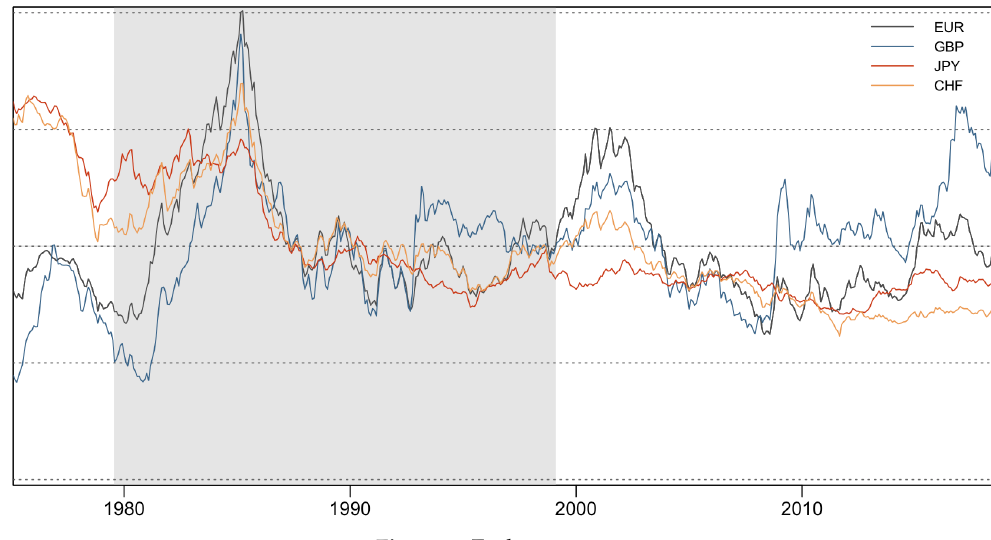
Figure 3. Exchange